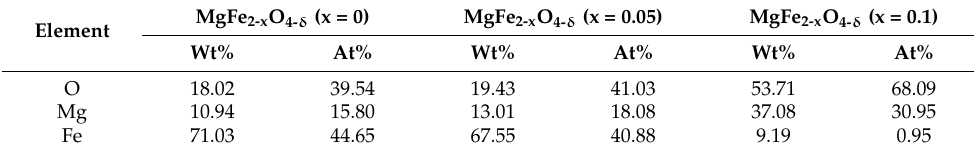
Table 2. EDS quantitative analysis of MgFe 2-x O 4- δ (x = 0, 0.05, and 0.1)